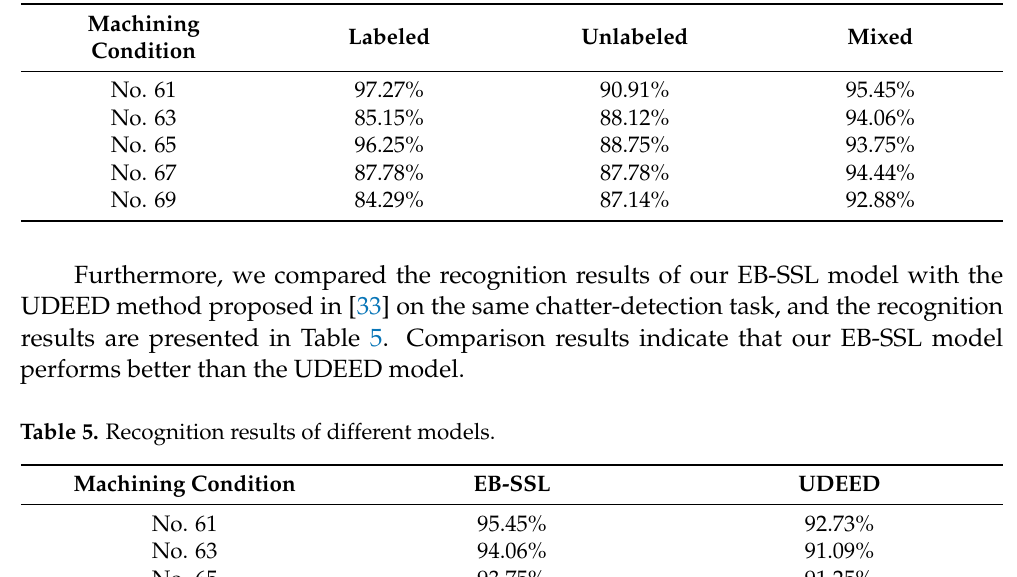
Table 4. Recognition accuracy with different training datasets.